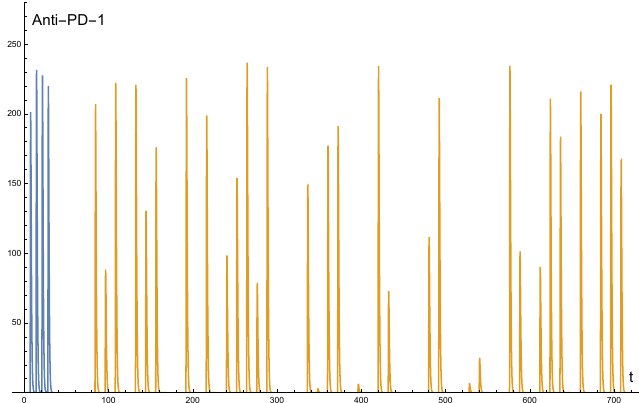
Figure 2. The y-axis represents the dosage of the ANTI PD-1 treatment and x-axis represents the time in days. The doses and the time of administration of the drug varied.